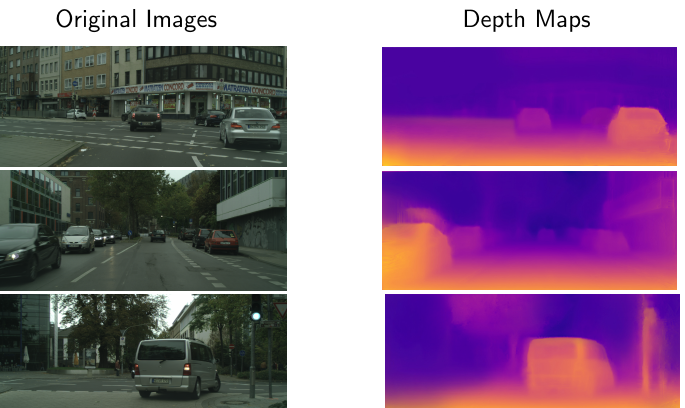
Figure 6. Results on the Cityscapes dataset [37]. The strongly reflective Mercedes-Benz logo is removed and only the top 80% of the output image is retained.